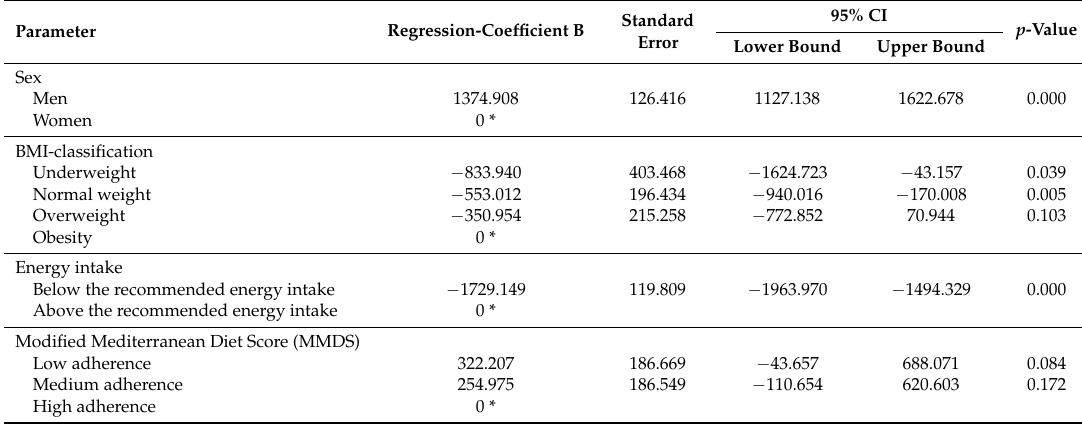
Table 4. Associations between salt intake and different